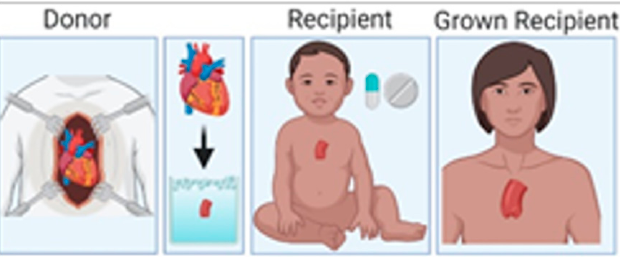
Figure 2. Partial heart transplantation involves transplanting the part of the heart containing the valve. Created with BioRender.com (accessed 1 November 2022).